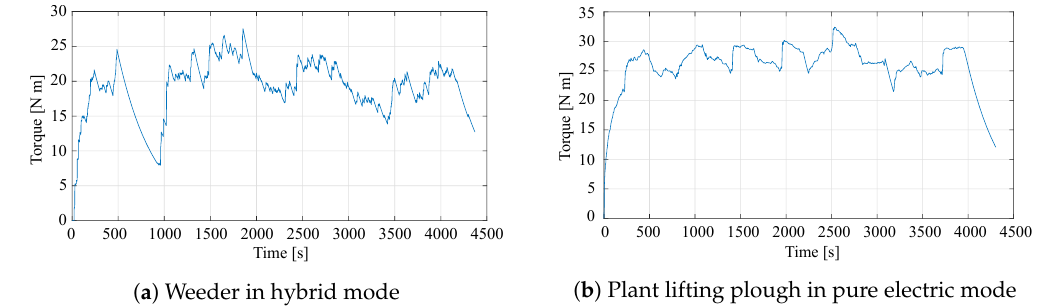
Figure 8. Thermal-equivalent torque required by the electric motor for different instruments and driving